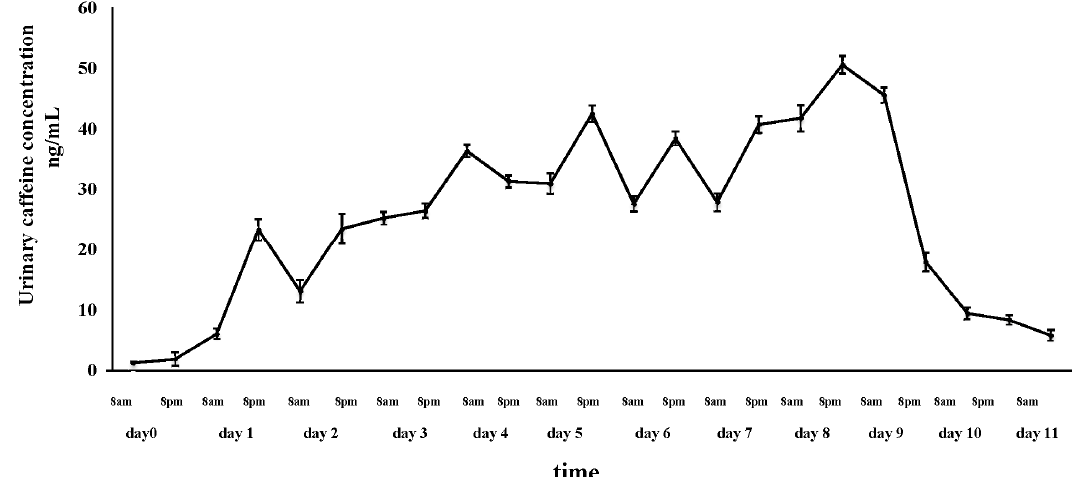
Figure 3. Time trend concentration of urinary caffeine during and after caffeine laced pants wearing (values are expressed as mean of three different determinations and Standard